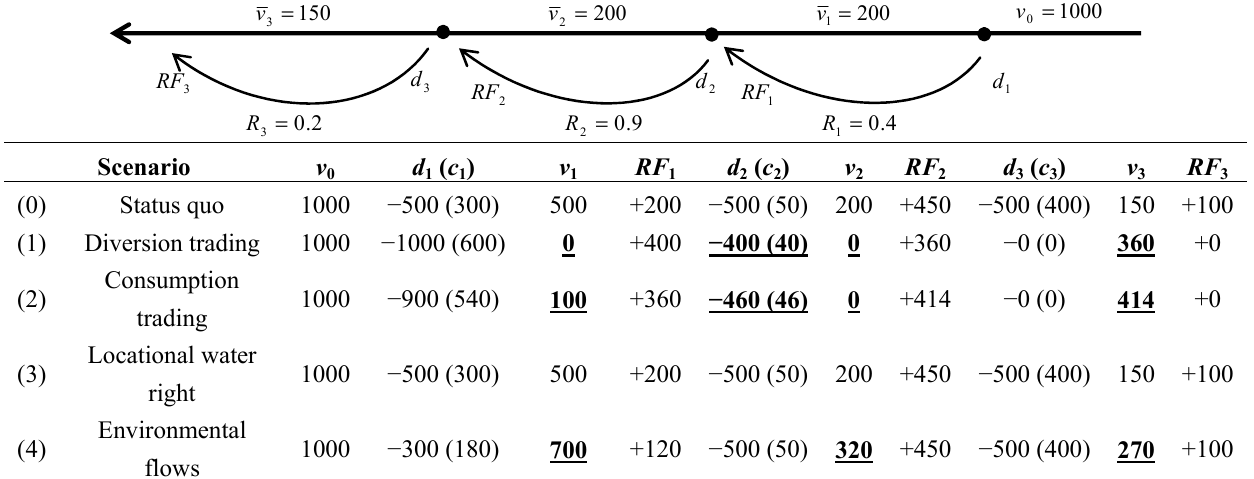
Table 1. Schematic diagram of a simplified river